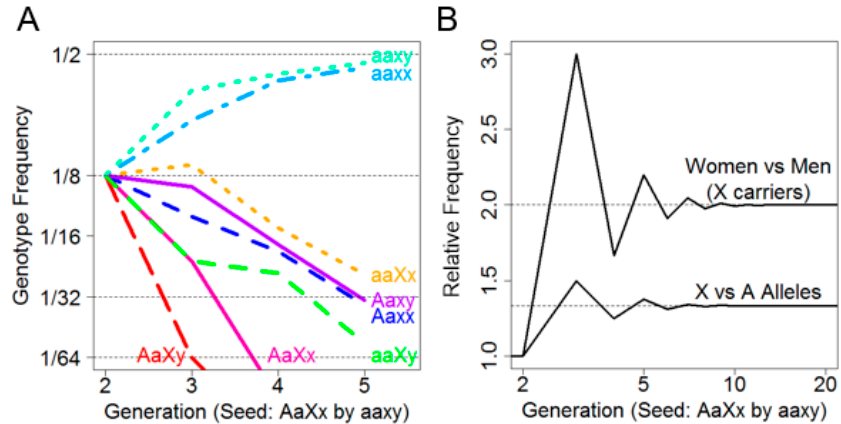
Figure 1. ( A ) (left): Transition probabilities over five generations showing decay towards the non-risk genotypes; and ( B ) (right): The sex ratio of X carriers showing a limiting behavior due to persistent carrier fathers.